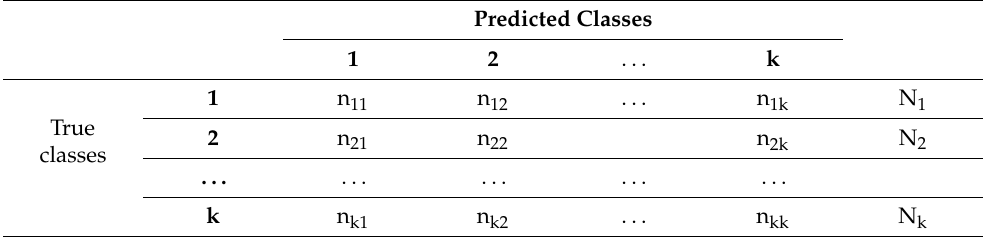
Table 3. Confusion matrix for k